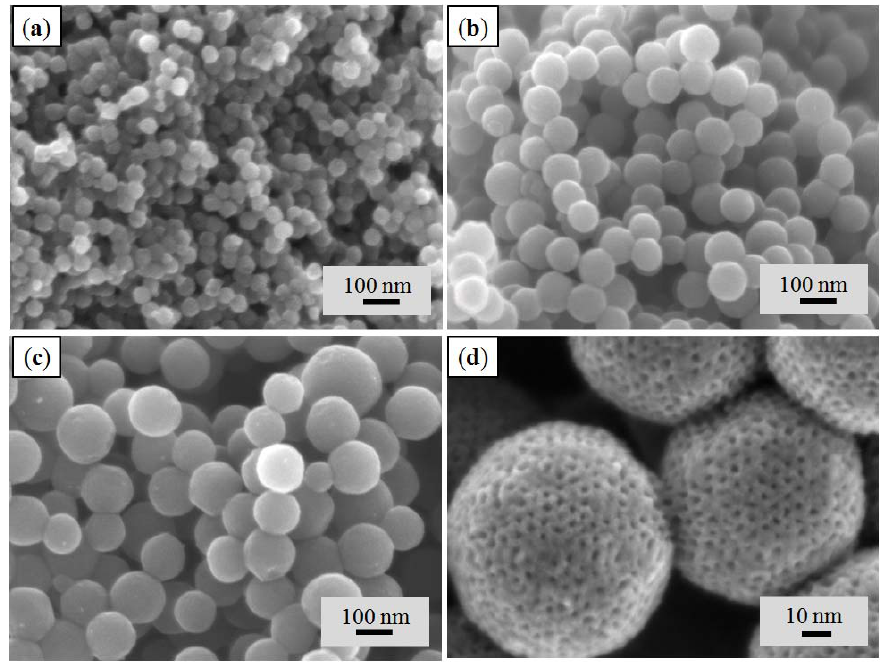
Figure 1. Scanning electron microscopy (SEM) images of ( a ) OMCS 7 , ( b ) OMCS 9 , ( c ) and ( d ) OMCS 11 obtained by dilution of phenolic resol/F127 to different volumes followed by hydrothermal method and calcination at 700 °C in N 2